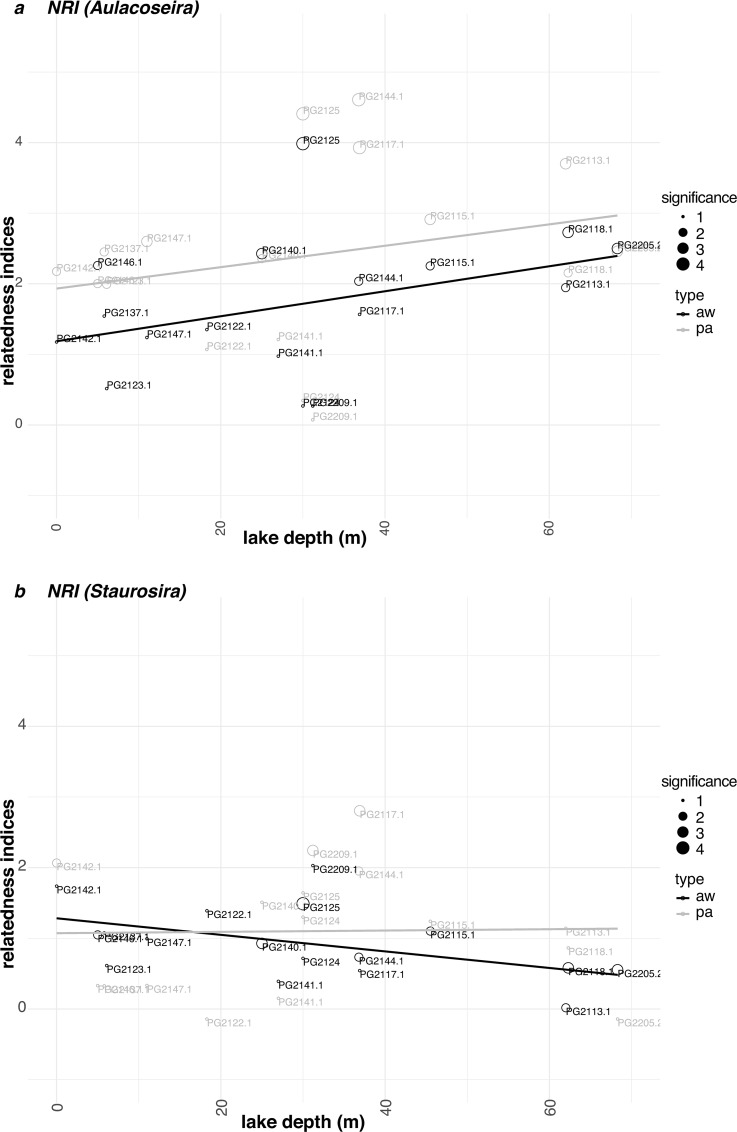
Relationships between diversity measures and water depth.Relationship between richness, lake water depth (m) and net relatedness index (NRI; = standardized effect size of mean phylogenetic distance (mpd) of observed vs. null communities) of sequence types of the genus Aulacoseira (a) and Staurosira (b) for the 17 intra-lake sampling sites. Significant deviations from null communities are indicated by the circle size (1 –p>0.05; 2 –p≤0.05; 3 –p≤0.01; 4 –p≤0.001).